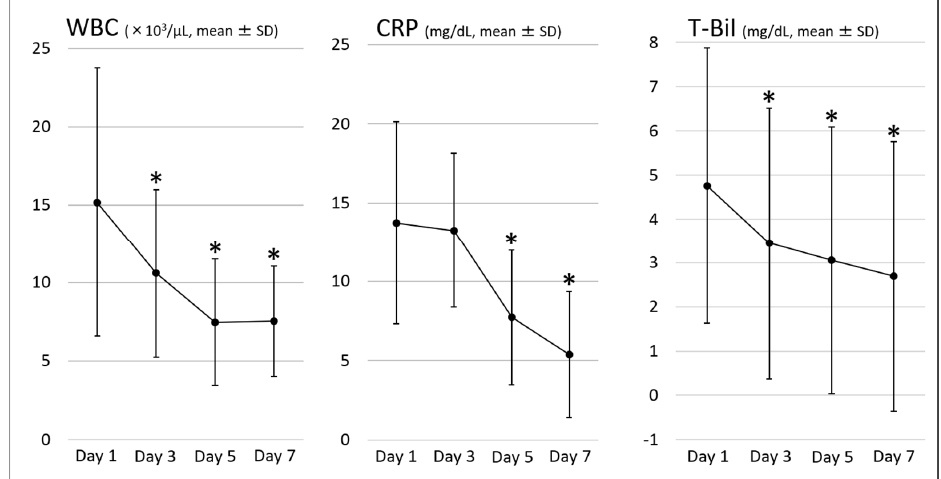
Figure 4. Parameters related to acute cholangitis. WBC, white blood cell; CRP, C-reactive protein; T-Bil, total bilirubin; * p < 0.05 vs. baseline.